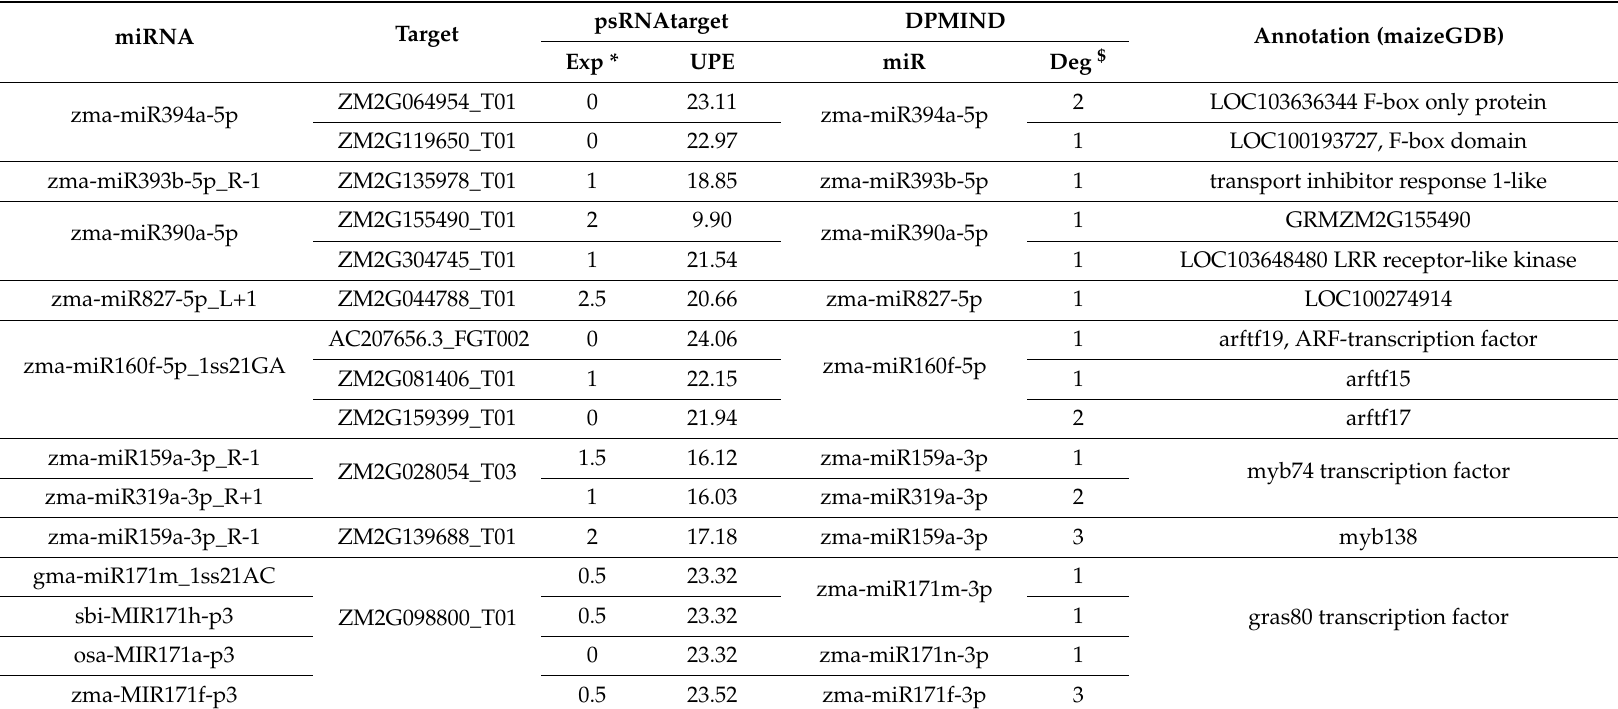
Table 4. The cleavable targets of maize xylem